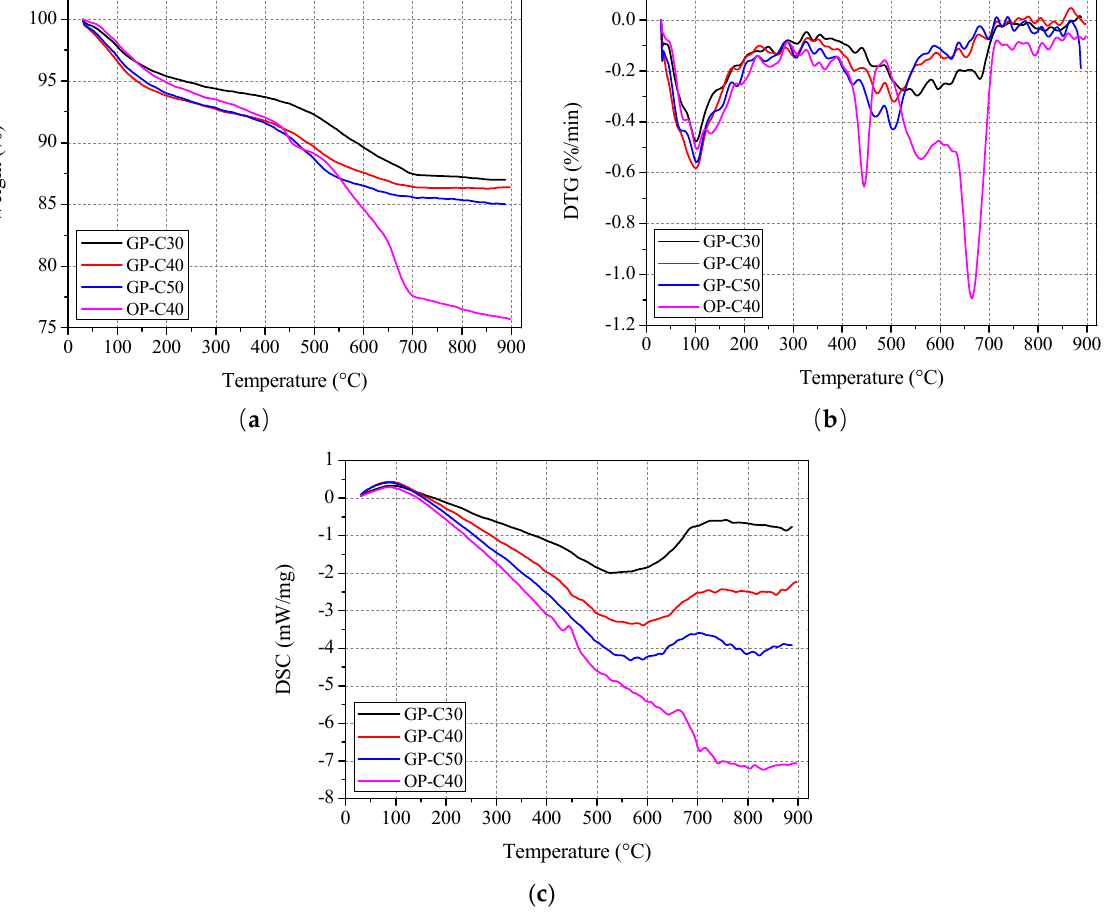
Figure 14. TGA/DSC results: ( a ) weight; ( b ) DTG and ( c ) DSC.